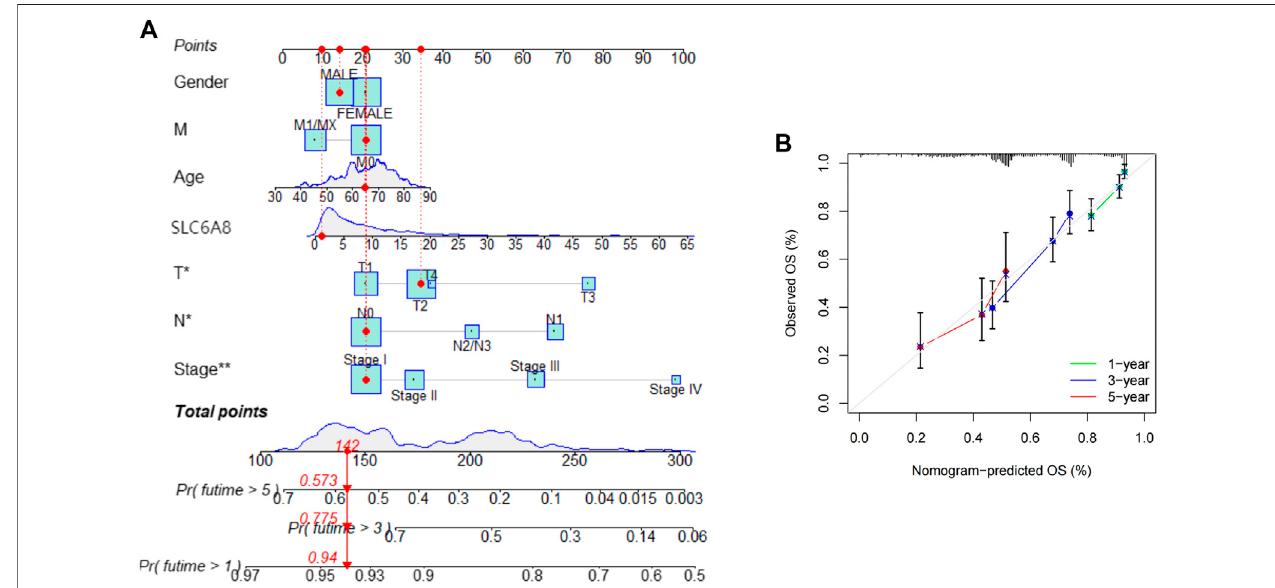
FIGURE7| Assessingthepracticalclinicalbeni fi tsof SLC6A8 (A) Constructionofanomogramsurvivalpredictionsystemincluding SLC6A8 expressionandclinical factors. (B) Plotting calibration curves for nomogram 1-, 2- and 5- year survival prediction curves.